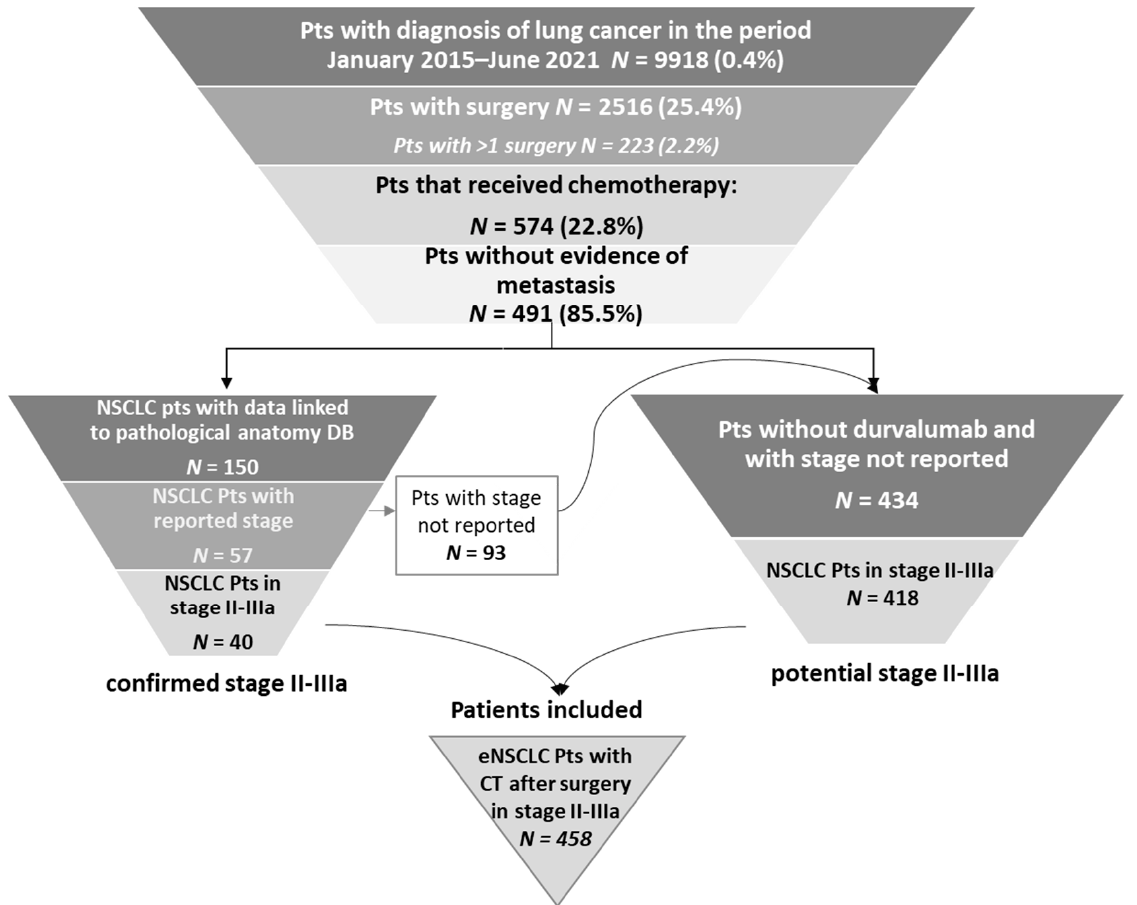
Figure 2. Sequential steps of the selection of NSCLC patients treated with chemotherapy after surgery in stage II–IIIA.Abbreviations: CT, chemotherapy; NSCLC, non-small-cell lung cancer; Pts, patients.